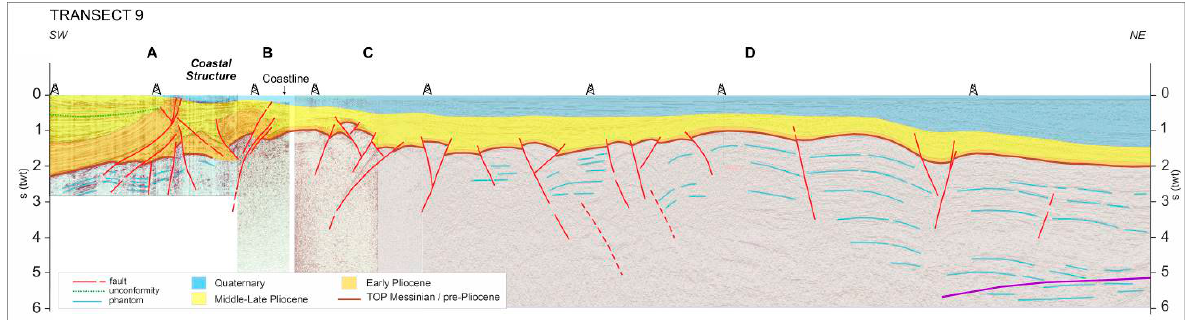
Figure 5 . Transect 9. The purple line shows the hypothetical basement. Geosciences 2021 , 11 , x FOR PEER REVIEW